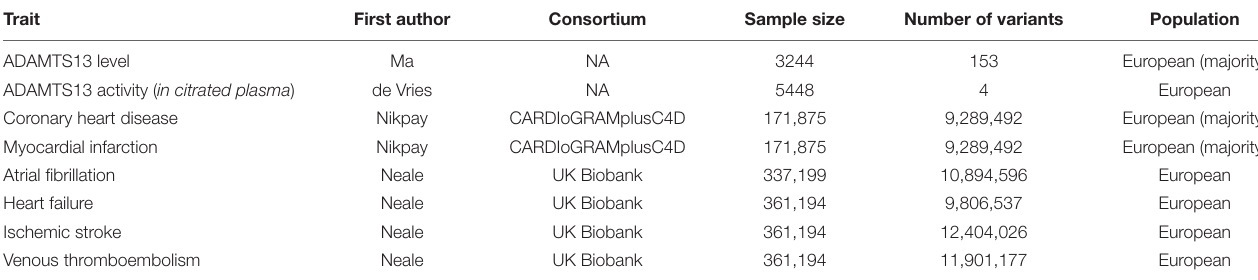
TABLE 1 | Characteristics of the SNP summary statistics for ADAMTS13 and outcomes.